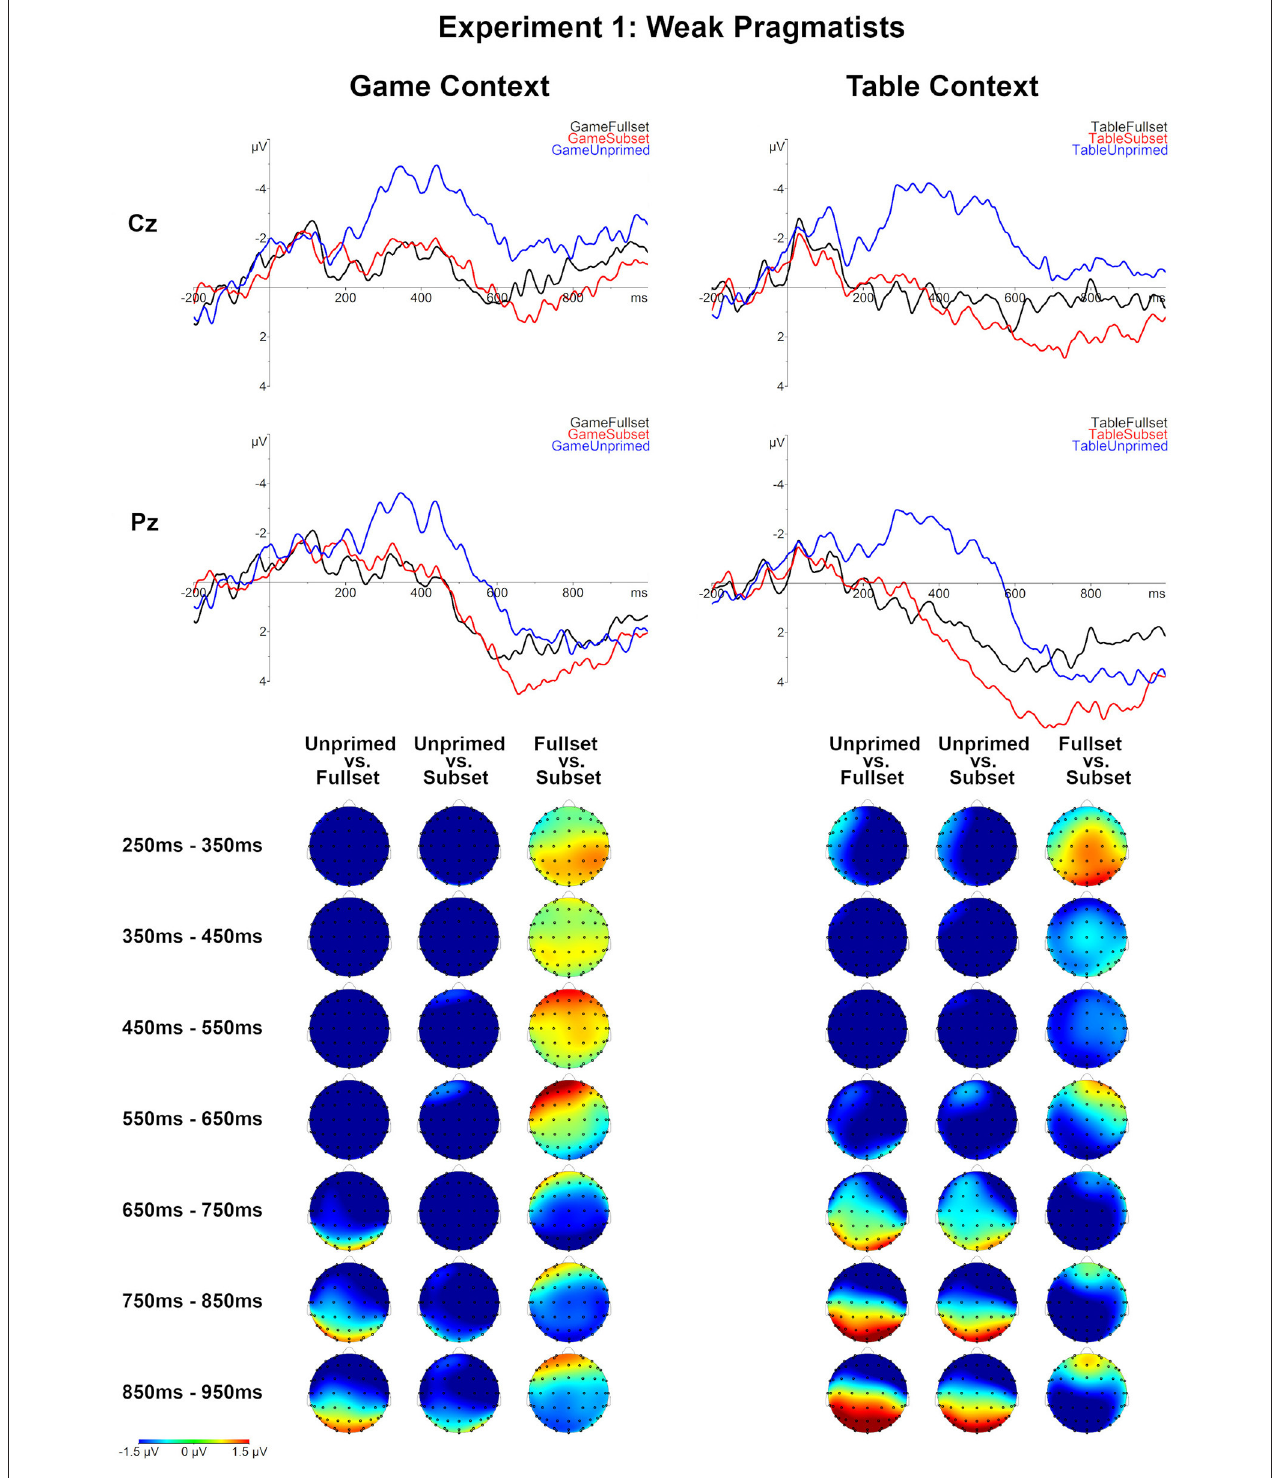
FIGURE 5 | Grand averages for all conditions for weak pragmatists ( N = 9), Experiment 1. Topographical maps of the differences between the compared Set levels separately for the Table and Game context in consecutive 100 ms time-windows, between 250 and 950 ms post-onset.